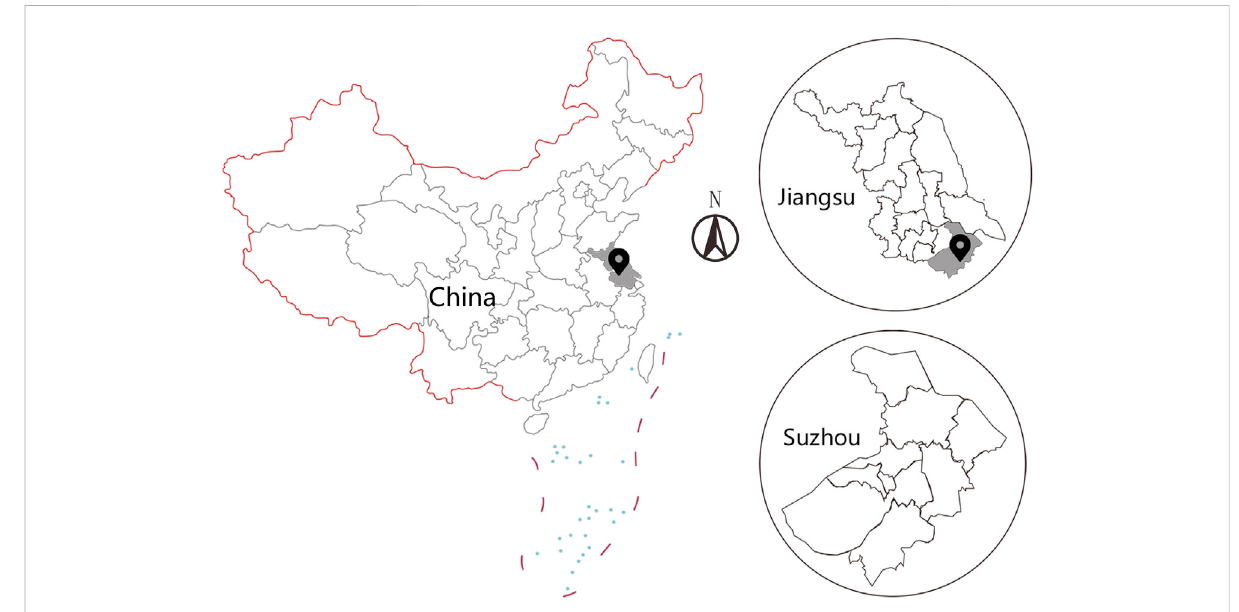
FIGURE 1 Overview of the research